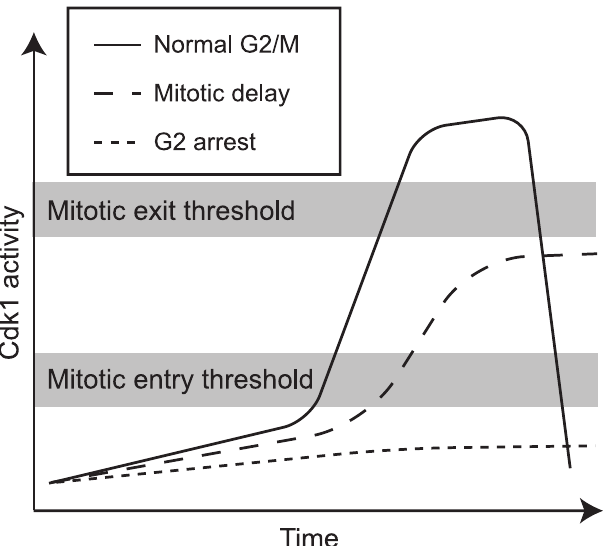
Figure 6. Different Cdk1 Activity Thresholds for Mitotic Entry and Mitotic Exit Model of relation between Cdk1 activity and mitotic progression. Cells do not enter mitosis unless a threshold concentration of active cyclin B1– Cdk1 is present (G 2 arrest). After mitotic entry, the Cdk1 activity gradually increases, which enables the cell to prepare for mitotic exit (normal G2/ M). If the Cdk1 activity does not develop fully after mitotic entry, the cell is delayed before anaphase (mitotic